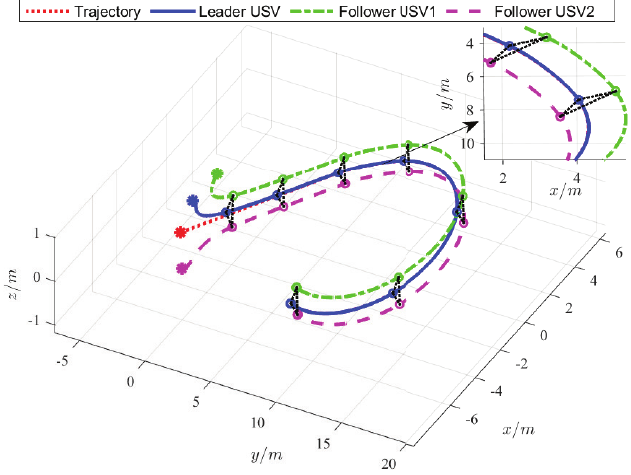
Figure 7. The curved path of USV formation.